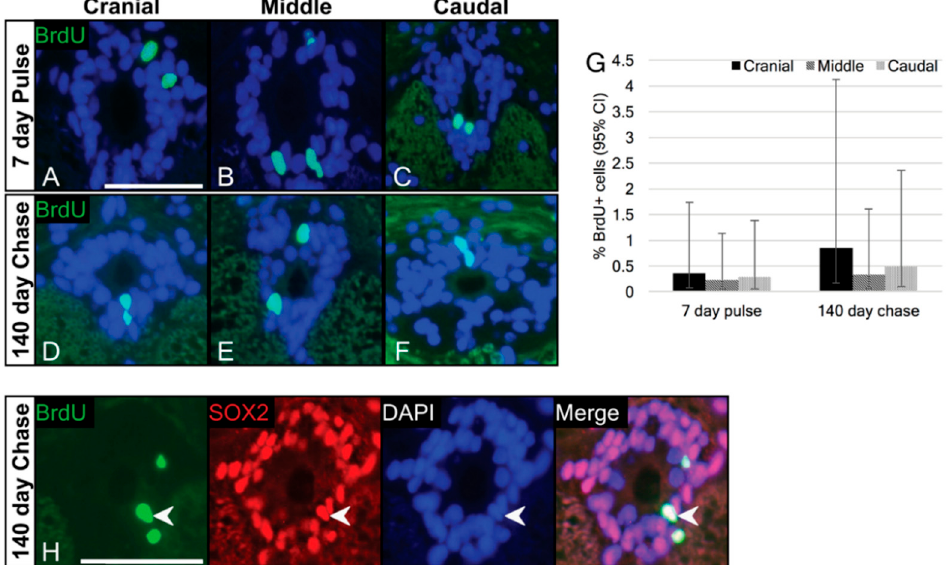
Figure 6. A subset of slow-cycling cells is present within the ependymal layer of the trunk. ( A – C ) After 7 days of pulse, BrdU+ cells are present in the ependymal layer of each the cranial ( A ), middle ( B ) and caudal ( C ) segments of spinal cord. ( D – F ) After 140 days of chase, BrdU+ cells are still present within the ependymal layer across the trunk spinal cord. ( G ) Quantification of BrdU+ cells in each segment after the pulse and 140-day chase time points. There are no significant regional differences in staining at the pulse or after the chase, nor are there significant differences between the pulse and 140-day chase. ( H ) A representative section from the cranial segment of the trunk spinal cord. BrdU co-localized with SOX2 at the 140-day chase time point (arrows). CI = confidence interval. Scale bars: ( A – F , H ) = 10 µ m. Table 2. Proportion of BrdU+ ependymal cells and 95% confidence intervals for the long-duration (7 day pulse, 140 chase) pulse-chase experiment. 95% Confidence Interval Chase (Days) Segment Mean (%) Lower